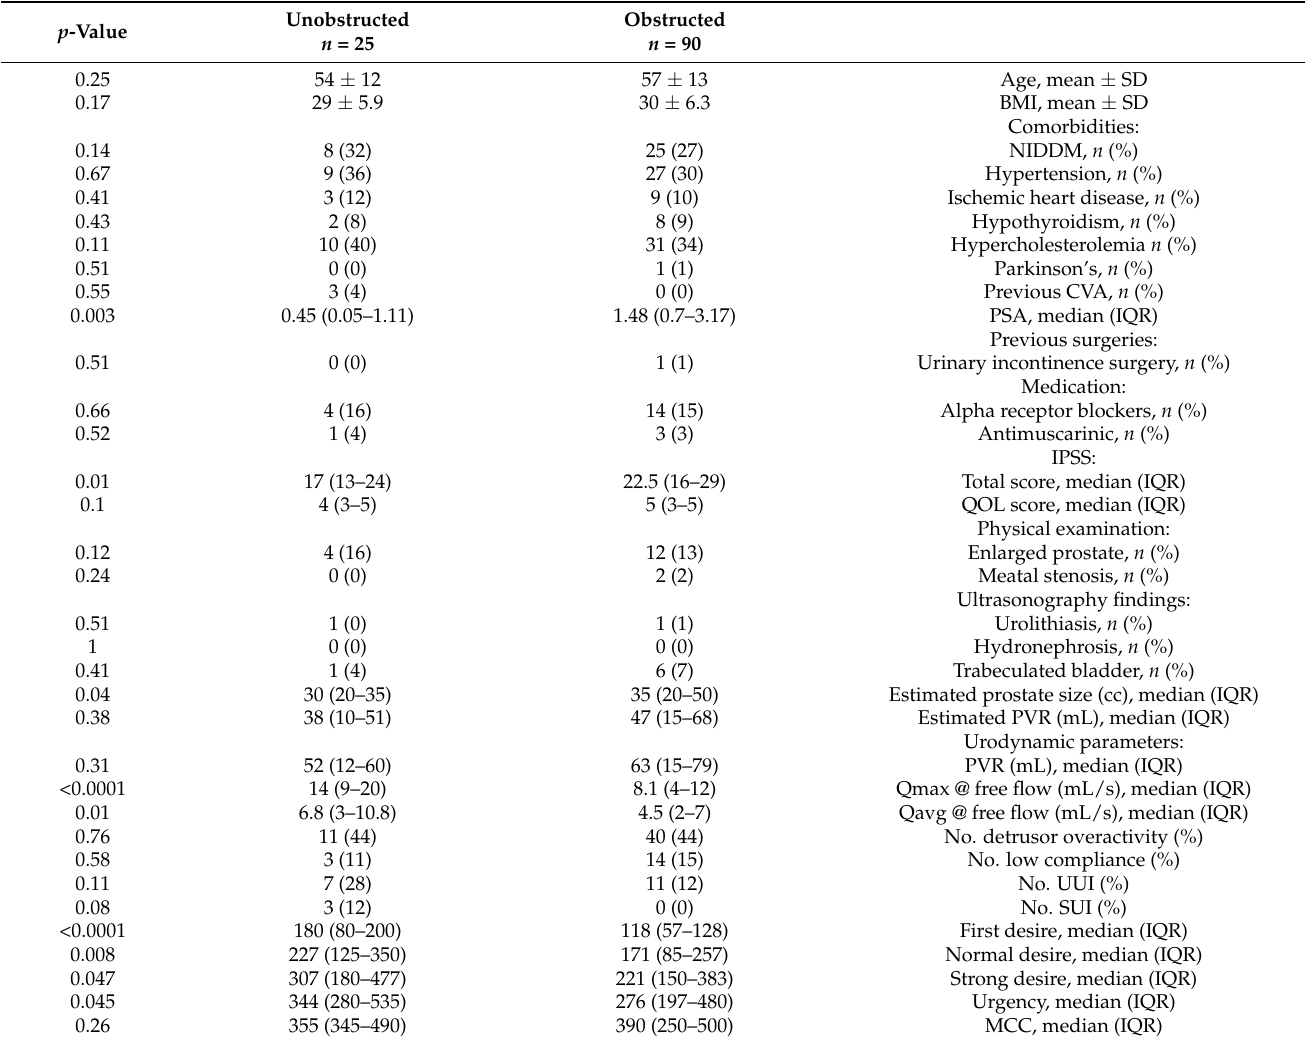
Table 1. Comparison of demographics, clinical and urodynamics variables between obstructed and unobstructed men.